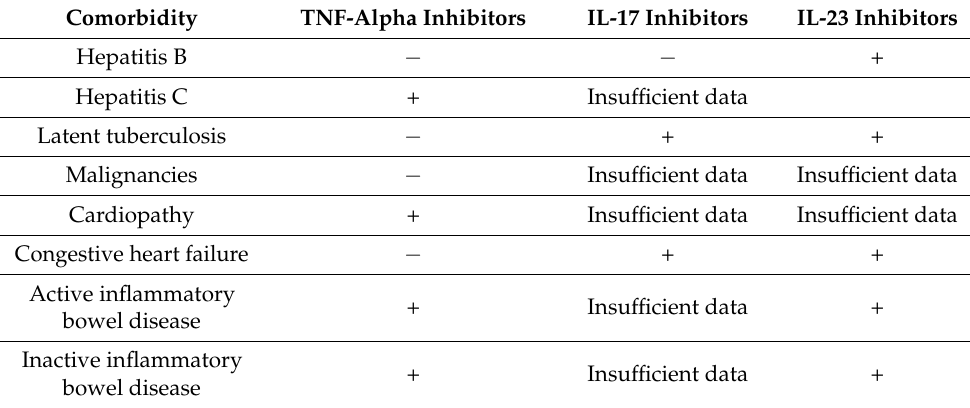
Table 2. Preferred and contraindicated biologic agents in the management of psoriasis in patients with concomitant